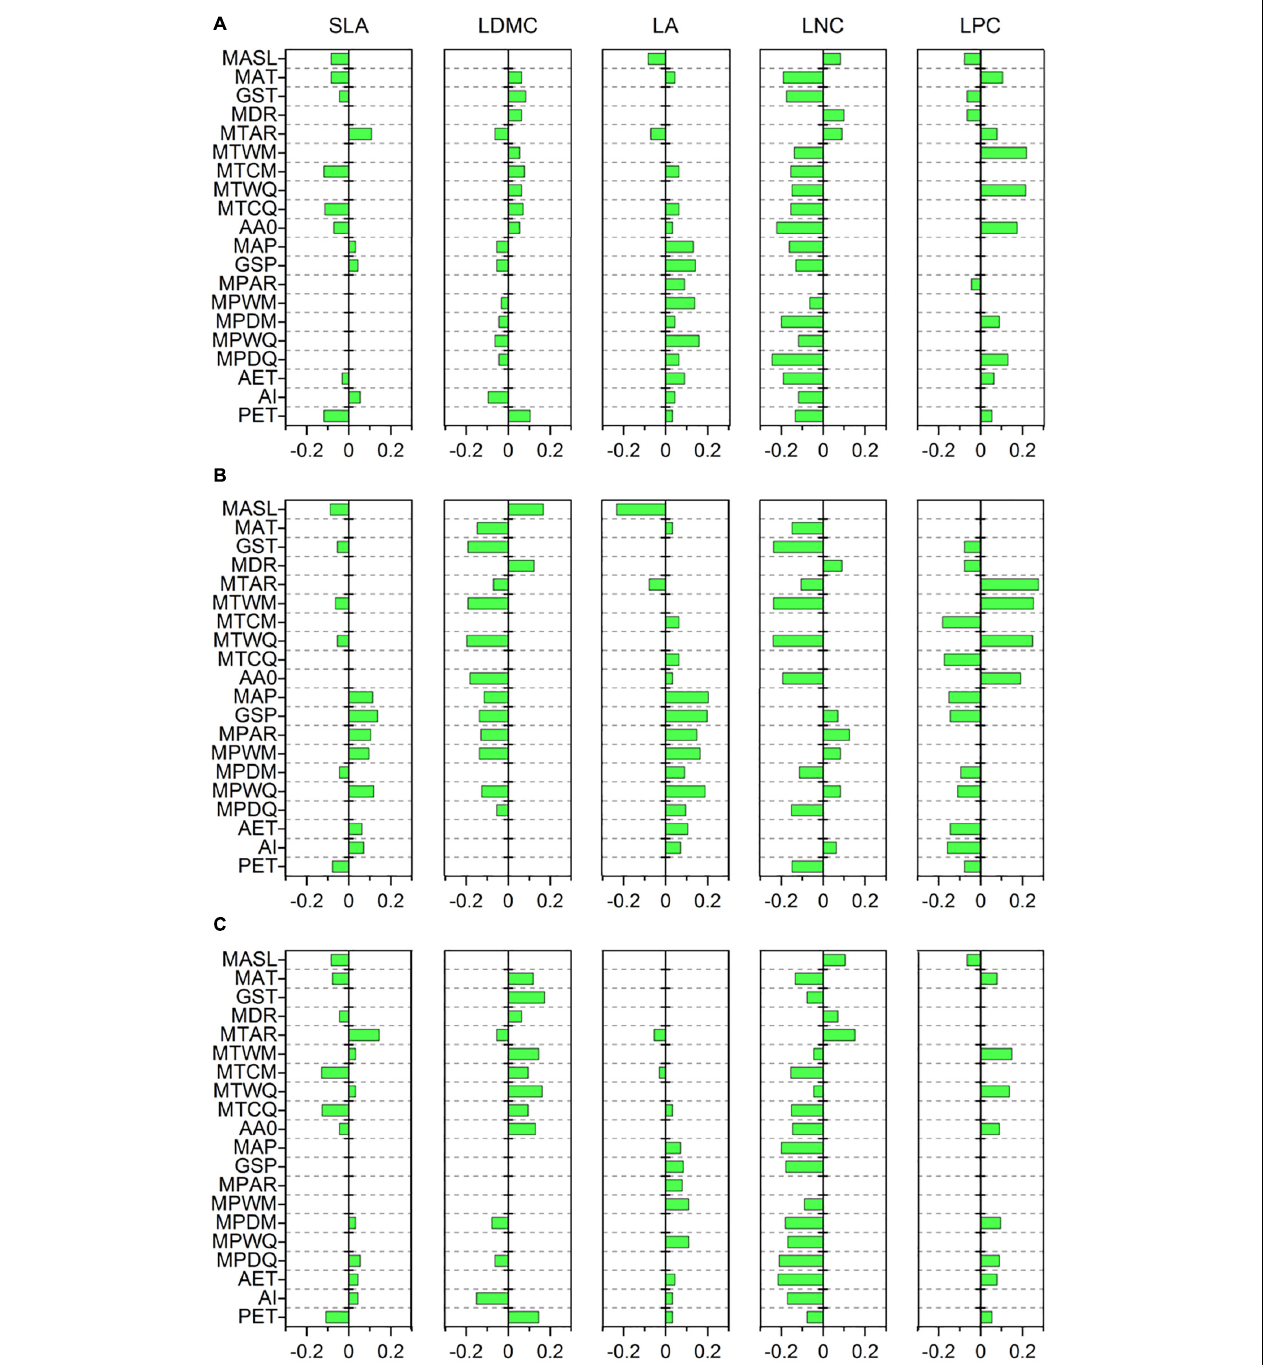
FIGURE 3 | Correlations of leaf traits with climate variables based on a phylogenetic linear mixed model (PLMM). Significant correlations between leaf traits and climate variables are shown ( p < 0.05). Positive values represent positive correlations between leaf traits and climate variables, while negative values represent negative correlations between them. (A) All species; (B) herbaceous species; (C) woody species. SLA, specific leaf area; LDMC, leaf dry matter content; LA, leaf area; LNC, leaf N concentration; LPC, leaf P concentration; MASL, mean annual sunlight; MAT, mean annual temperature; GST, mean growing season temperature; MDR, mean diurnal range; MTAR, mean annual range of temperature; MTWM, mean temperature of the warmest month of a year; MTCM, mean temperature of the coldest month of a year; MTWQ, mean temperature of the warmest quarter of a year; MTCQ, mean temperature of the coldest quarter of a year; AA0, active accumulated temperature above 0 ◦ C; MAP, mean annual precipitation; GSP, mean growing season precipitation; MPAR, mean annual range of precipitation; MPWM, mean precipitation of the wettest month of a year; MPDM, mean precipitation of the driest month of a year; MPWQ, mean precipitation of the wettest quarter of a year; MPDQ, mean precipitation of the driest quarter of a year; AET, actual evapotranspiration; AI, aridity index; PET, potential evapotranspiration.